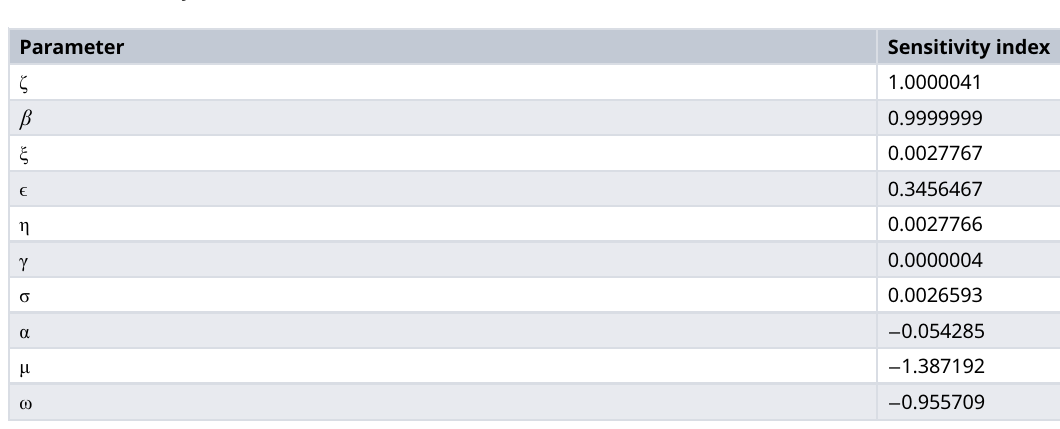
Table 2. Sensitivity indices on R0.